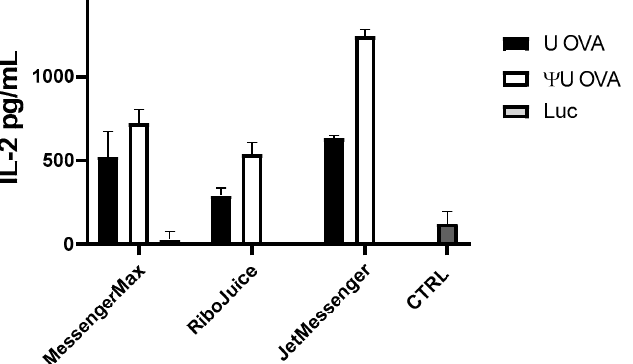
Figure 3. OT1 murine splenocytes were cultivated for 24 h with ovalbumin-coding (OVA) or luciferase-coding (Luc) mRNA. Ovalbumin-coding mRNA induced an adaptive immune response in OT1 cells, which is indicated by elevated IL-2 levels. Non-transfected OT1 cells served as the negative control group (CTRL). Data represent triplicate mean values; error bars: SD.